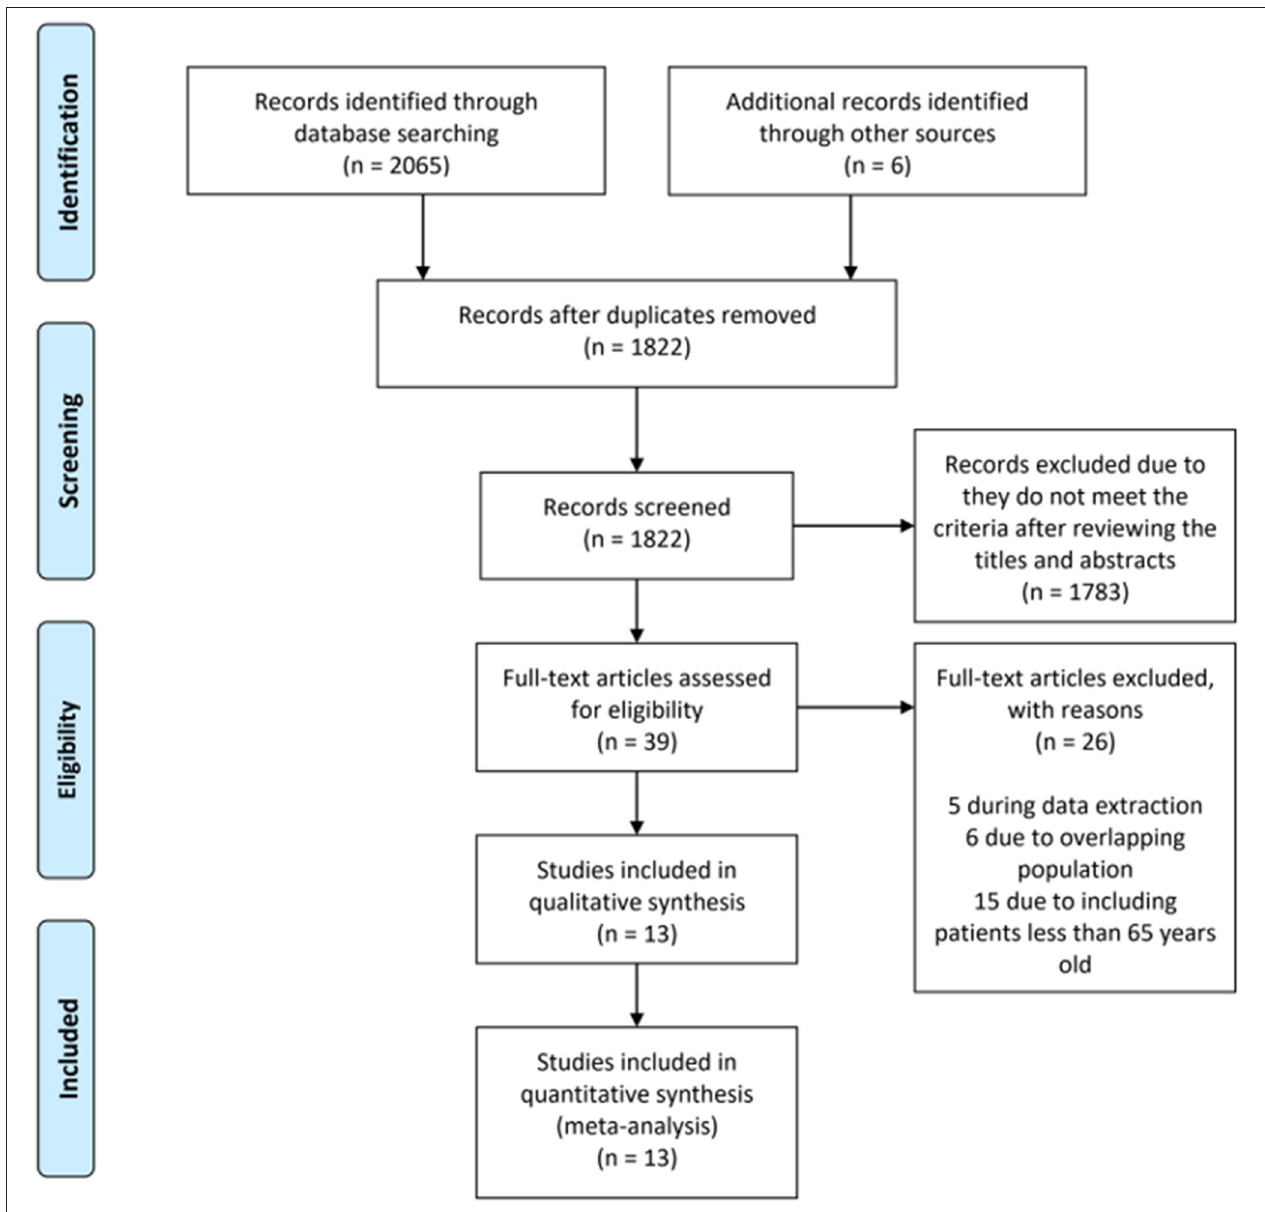
FIGURE 1 | Preferred reporting items for systematic reviews and meta-analyses flow diagram.